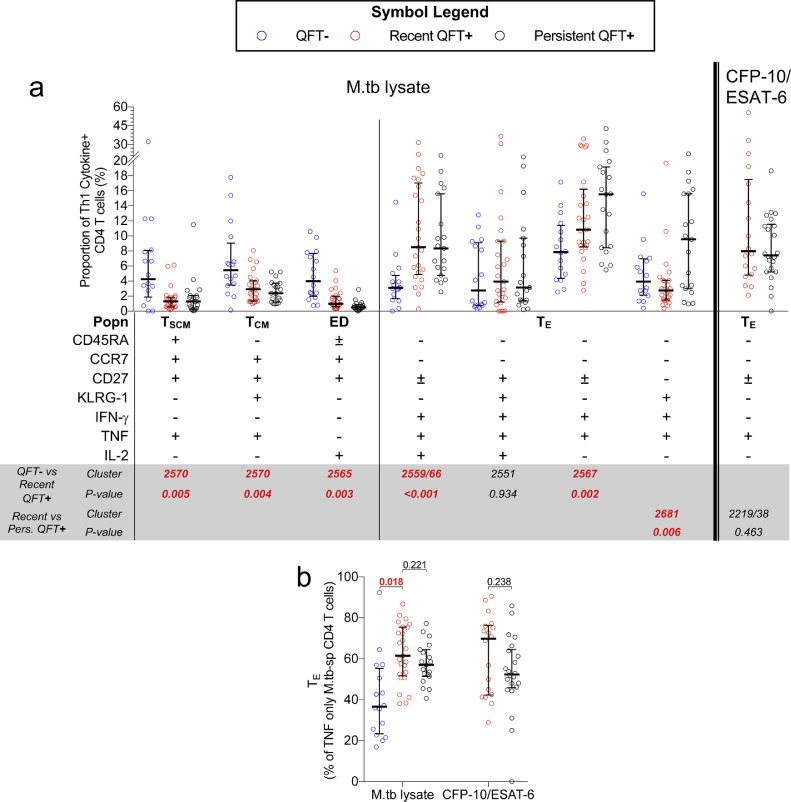
Induction of highly differentiated polyfunctional TE cells upon recent QFT conversion at the expense of less differentiated IFN-γ-independent TSCM and TCM subsets. Proportions of (a) M.tb lysate-specific and CFP-10/ESAT6-specific memory/cytokine co-expression subsets before (QFT−, blue, M.tb lysate, n= 16), after (recent QFT+, red, CFP-10/ESAT-6, n= 18; M.tb lysate, n=25), and during persistent M.tb infection (persistent QFT+, black, CFP-10/ESAT-6, n= 22; M.tb lysate, n=19). The CITRUS cluster number corresponding to the manually gated populations is shown. (b) Proportions of TE TNF only M.tb lysate-specific and CFP-10/ESAT-6-specific CD4 T cells detected before, after and during persistent M.tb infection (number of participants is as in A). Statistical analysis was conducted as in Fig. 2, clusters and p-values highlighted in red, bold text were considered significantly different.